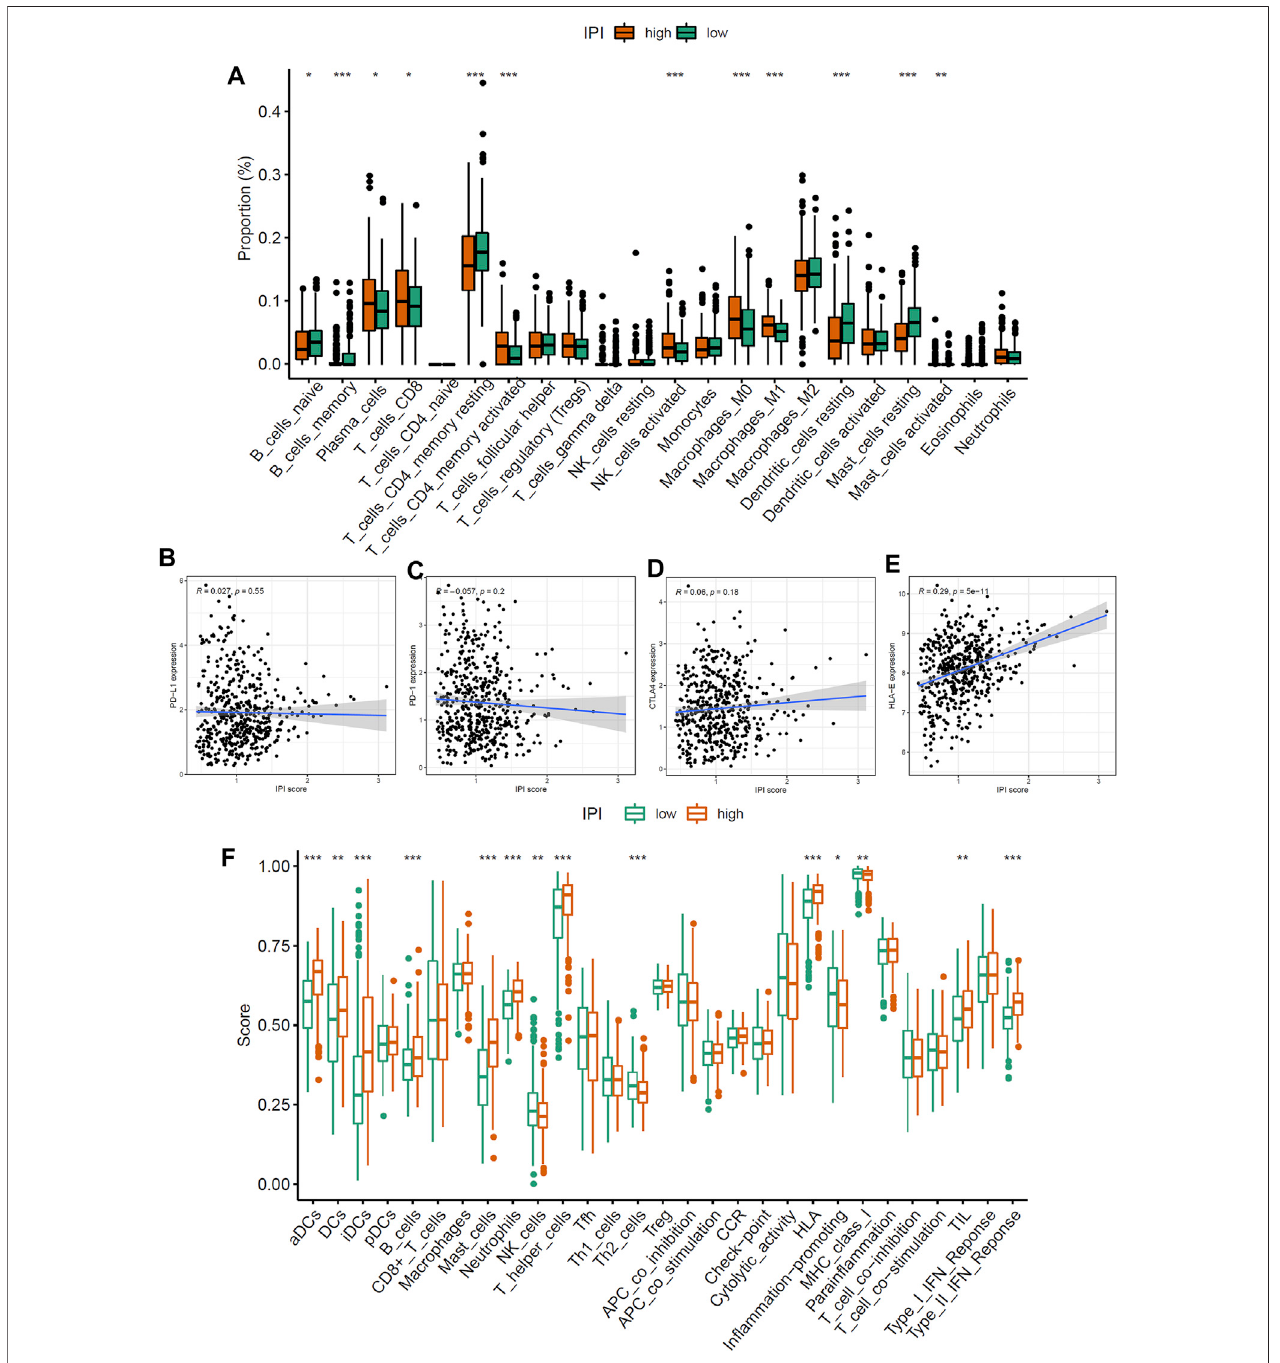
FIGURE 4 | Immune characteristics of IPI subgroups. (A) The proportion difference of 22 immune cells in IPI subgroups in LUAD patients (* p < 0.05, ** p < 0.01, *** p < 0.001). (B – D) The relationship between IPI scores and PD-1/PD-L1 and CTLA4 ( p > 0.05). (E) The relationship between IPI scores and HLA-E ( p < 0.05). (F) The difference of immune and molecular functions of IPI subgroups in LUAD patients (* p < 0.05, ** p < 0.01, *** p < 0.001).